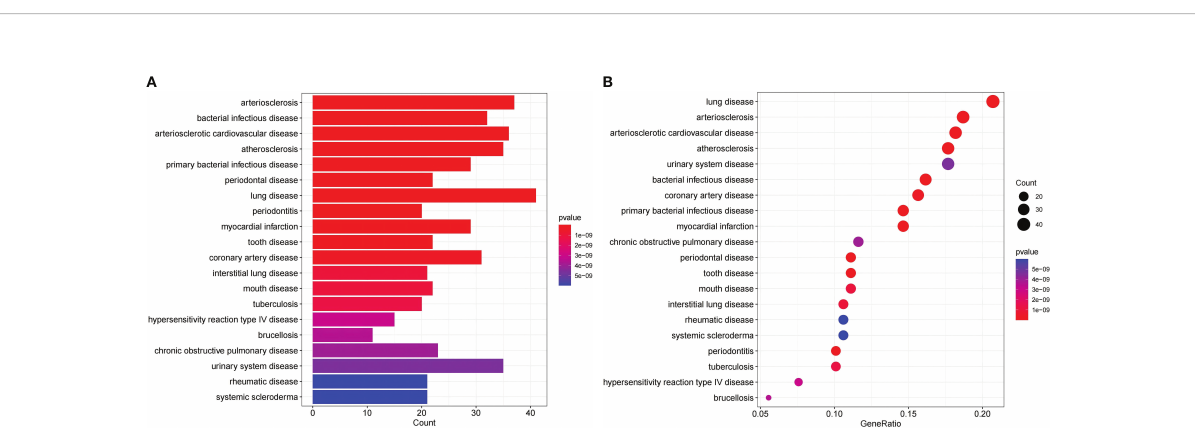
FIGURE 4 DO enrichment analysis shows the correlation between MI and the DEGs; (A) The x-axis of the bar chart displays the number of genes, and the y- axis displays the correlative diseases. (B) The x-axis of the bubble plot shows the ratio of the genes, and the y-axis shows the correlative